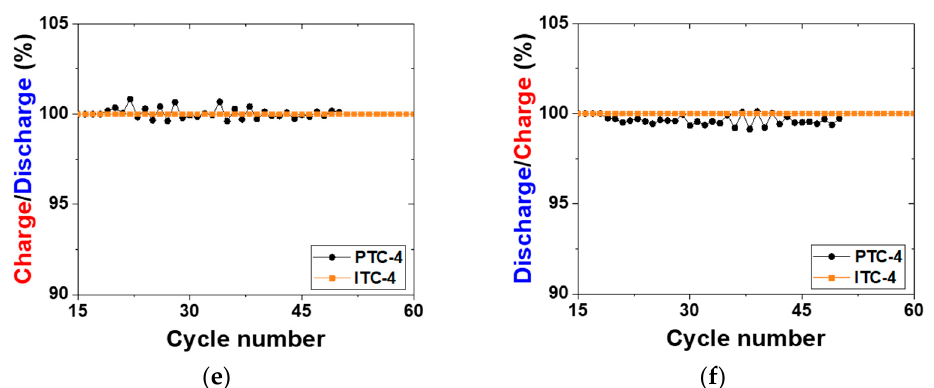
Figure 4. Electrochemical properties of test cells. ( a , b ) Voltage charge capacity profile of previous test cells and improved test cells for reproducibility analysis; ( c , d ) cycling performance of PTC-4 and ITC-4; ( e ) charge capacity ((n + 1)th cycle) divided by discharge capacity (nth cycle) profile; ( f ) discharge capacity (nth cycle) divided by charge capacity (nth cycle) profile.